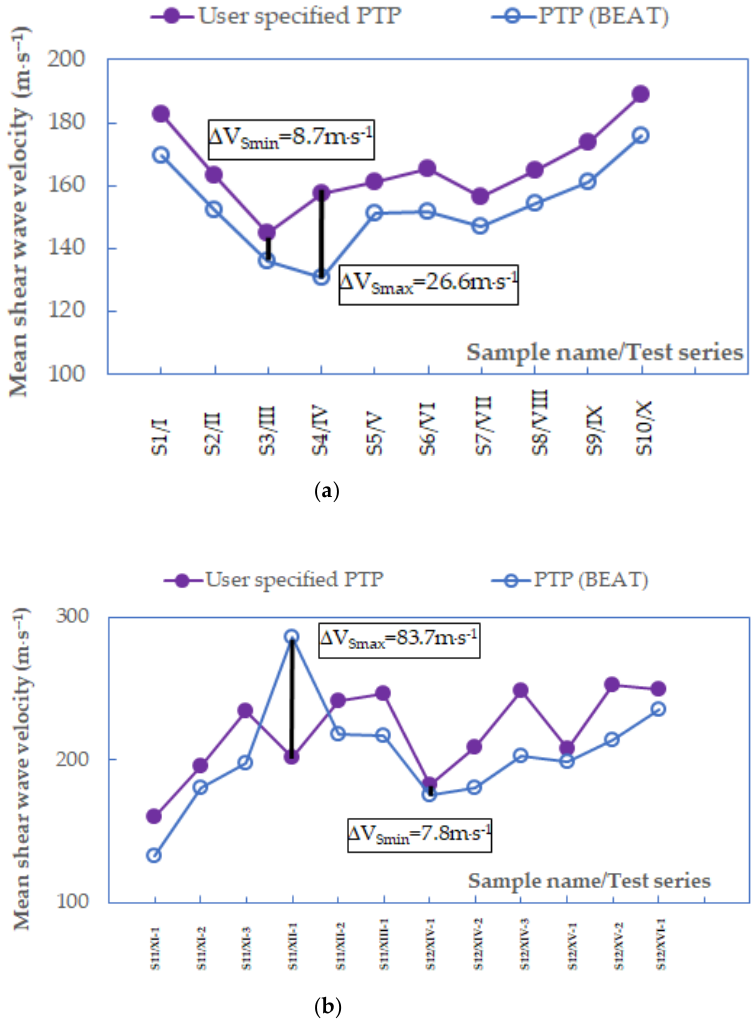
Figure 12. Mean values of shear wave velocities from peak-to-peak methods when f < 3.3 kHz, data for specimens ( a ) S1 − S10 and ( b ) S11–S12.